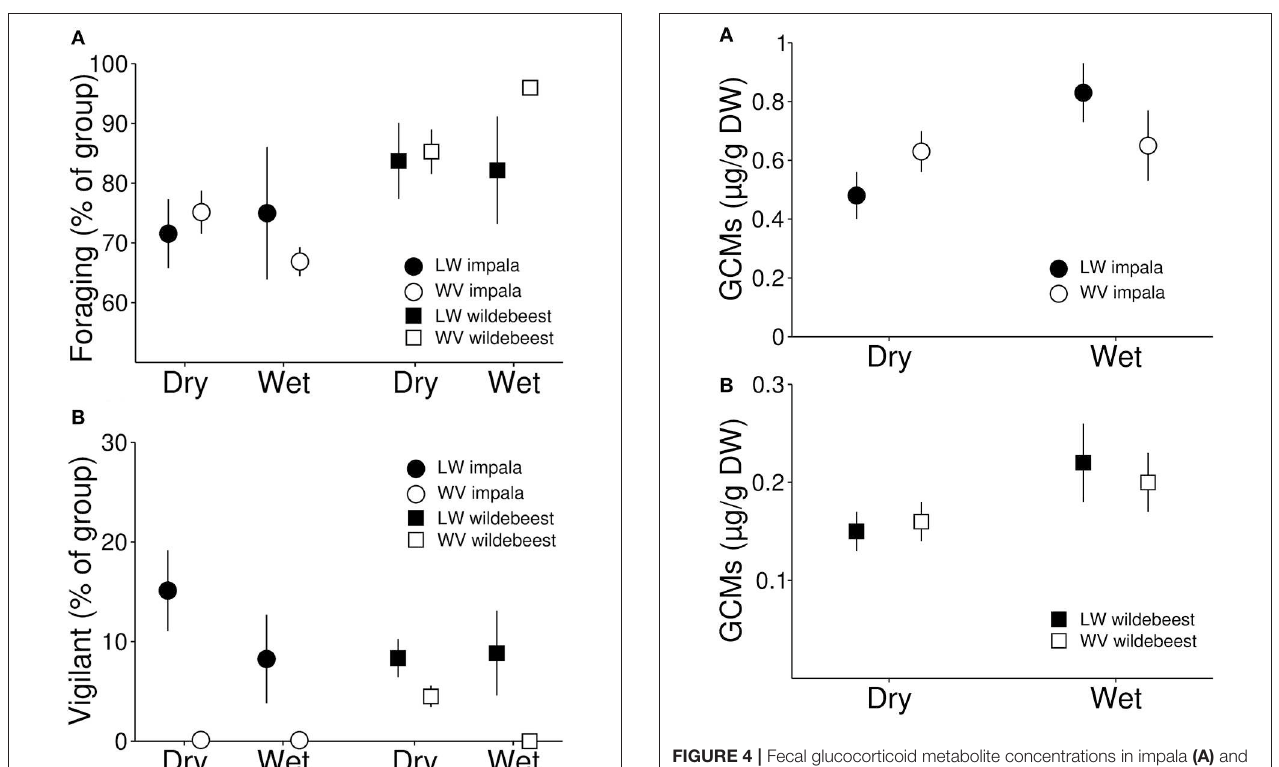
FIGURE 4 | Fecal glucocorticoid metabolite concentrations in impala (A) and wildebeest (B) living in Lapalala and Welgevonden during the dry and wet season. Data comes from 119 individual samples collected from 31 groups of impala and 24 groups of wildebeest in Lapalala and from 14 groups of impala and 26 groups of wildebeest in Welgevonden. The figure represents means of group means ± 1